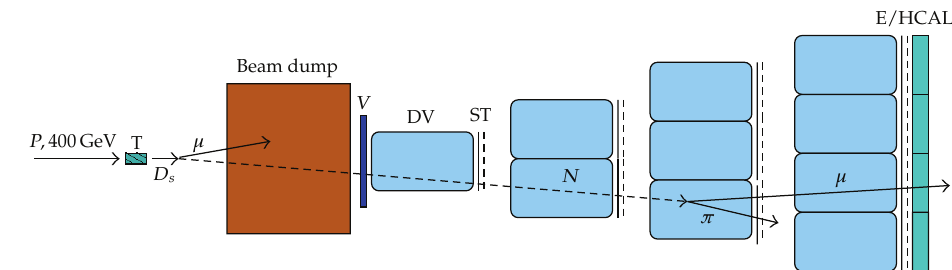
Figure 8: Schematic illustration of a proton beam dump experiment on search for D s → μN,N → μπ decay chain: charm mesons D s generated by the proton beam in the target (cid:2) T (cid:3) produce a flux of high energy N ’s through the U μN mixing in the decay D s → μν μ , which penetrate the downstream shielding and decay into μπ pair in a neutrino decay volume (cid:2) DV (cid:3) . The same setup can be used to search for the process N → μeν . See